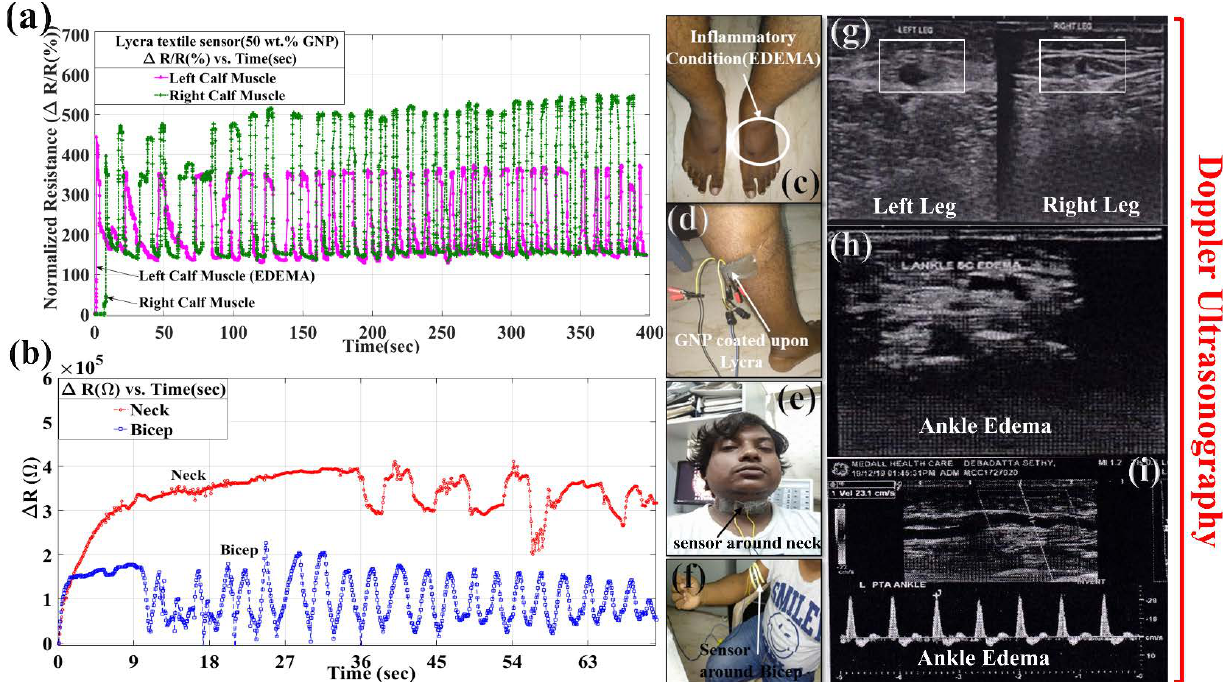
Figure 11. Experimental setup for electrical resistance data analysis by wearable Lycra denim sensor coated with GNPs and sol–gel solutions: ( a ) Normalized resistance change at left and right calf muscles for edema detection by smart Lycra textile sensor (coated with GNPs and sol–gel solutions); ( b ) change in resistance for neck and biceps detected by smart Lycra textile sensor (coated with GNPs and sol–gel solutions); ( c – f ) inflammation showing edema at ankle , Lycra textile sensor attached at calf muscle, neck, and biceps, respectively; ( g – i ) Doppler ultrasonography for confirmation of EDEMA.